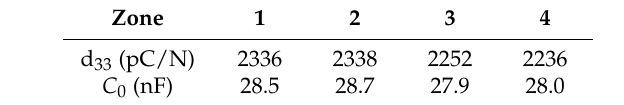
Table 1. The measured d 33 and the C 0 of the multilayer piezoelectric ceramic.